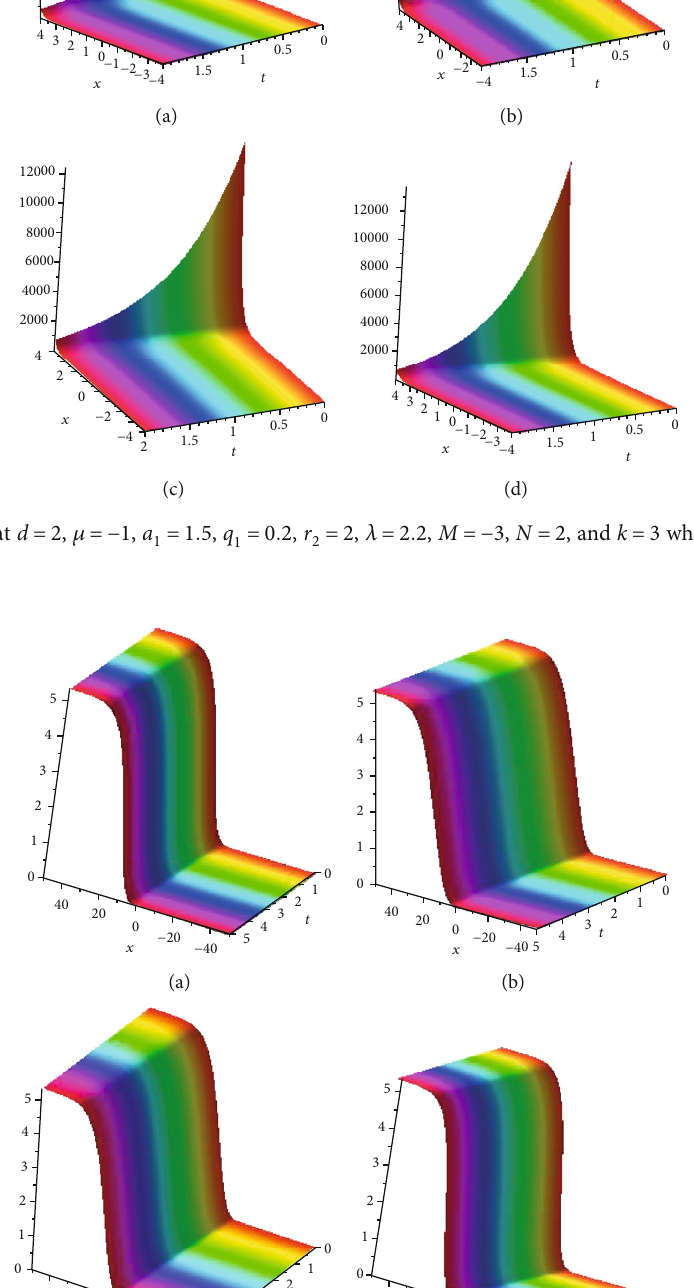
Figure 4: The 3D plot of (59) at d = 0 : 2 , μ = − 1 , q and (d) α = 0 : 99